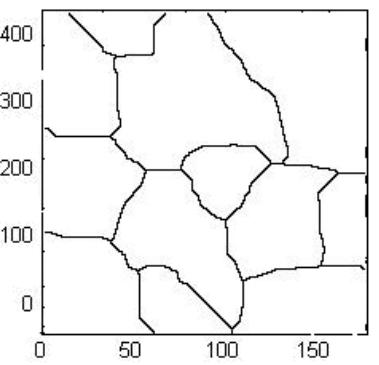
Figure 11. Watershed segmentation to establish regions of possible particles.